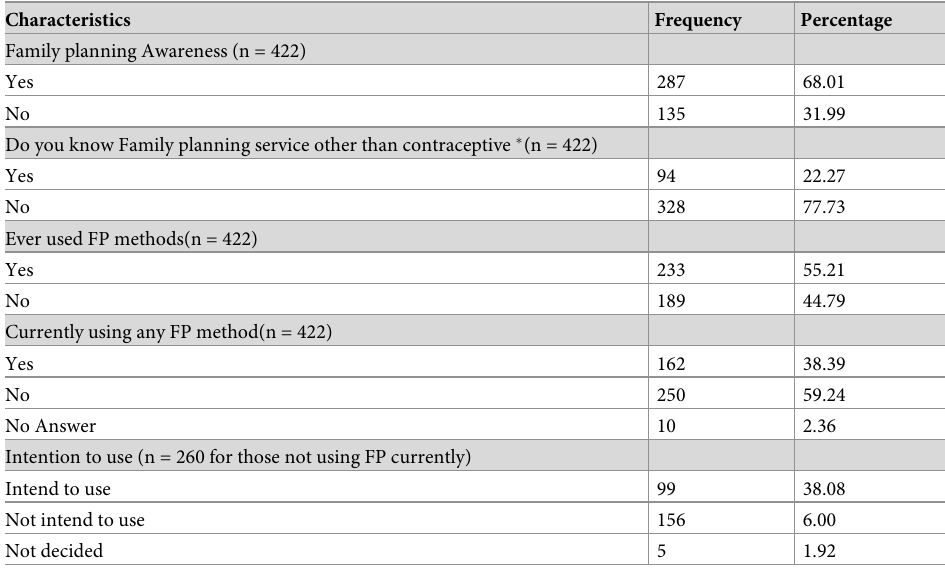
Table 3. Awareness and use of family planning among